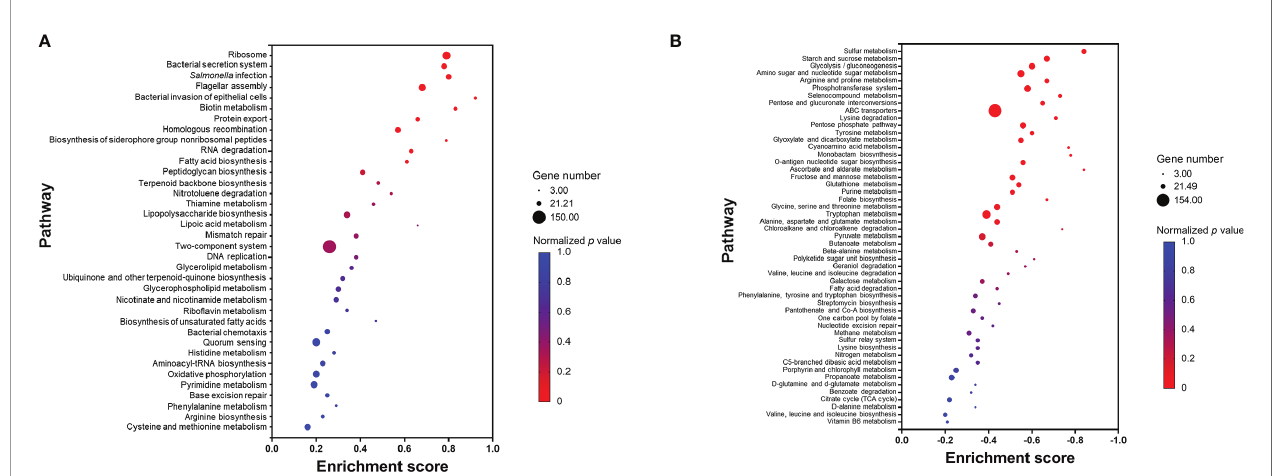
FIGURE 7 | Pathways that are upregulated (A) or downregulated (B) based on gene set enrichment analysis (GSEA). Each pathway is represented by a dot; the size, color, and enrichment score value of the dot represents the total number of genes within the pathway, normalized p value, and proportion of the genes in the pathway considered as core enrichment, respectively.